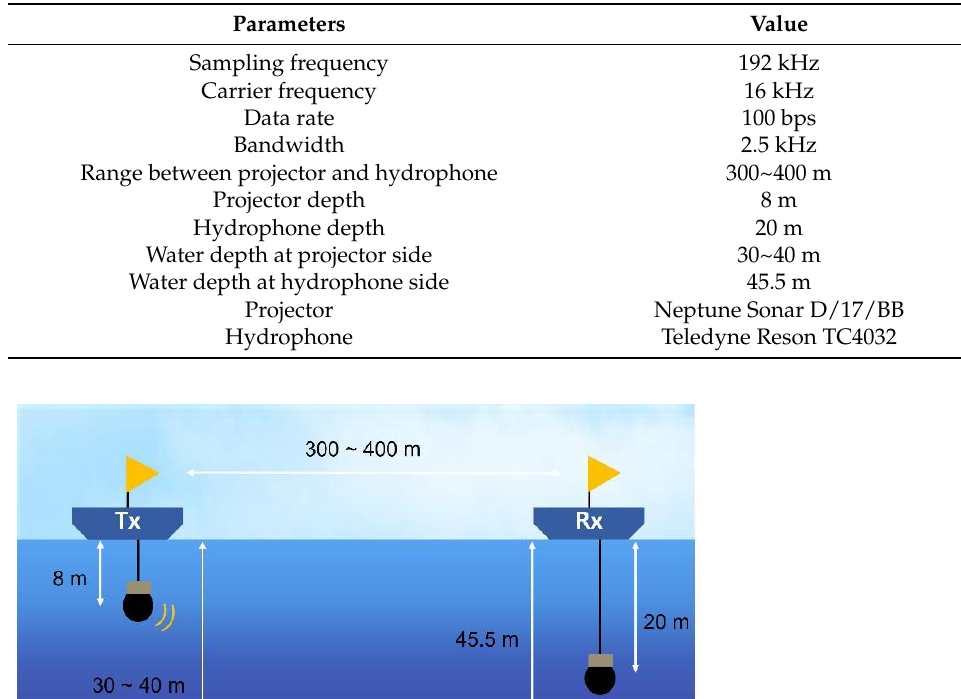
Table 2. Parameters for the lake trial.